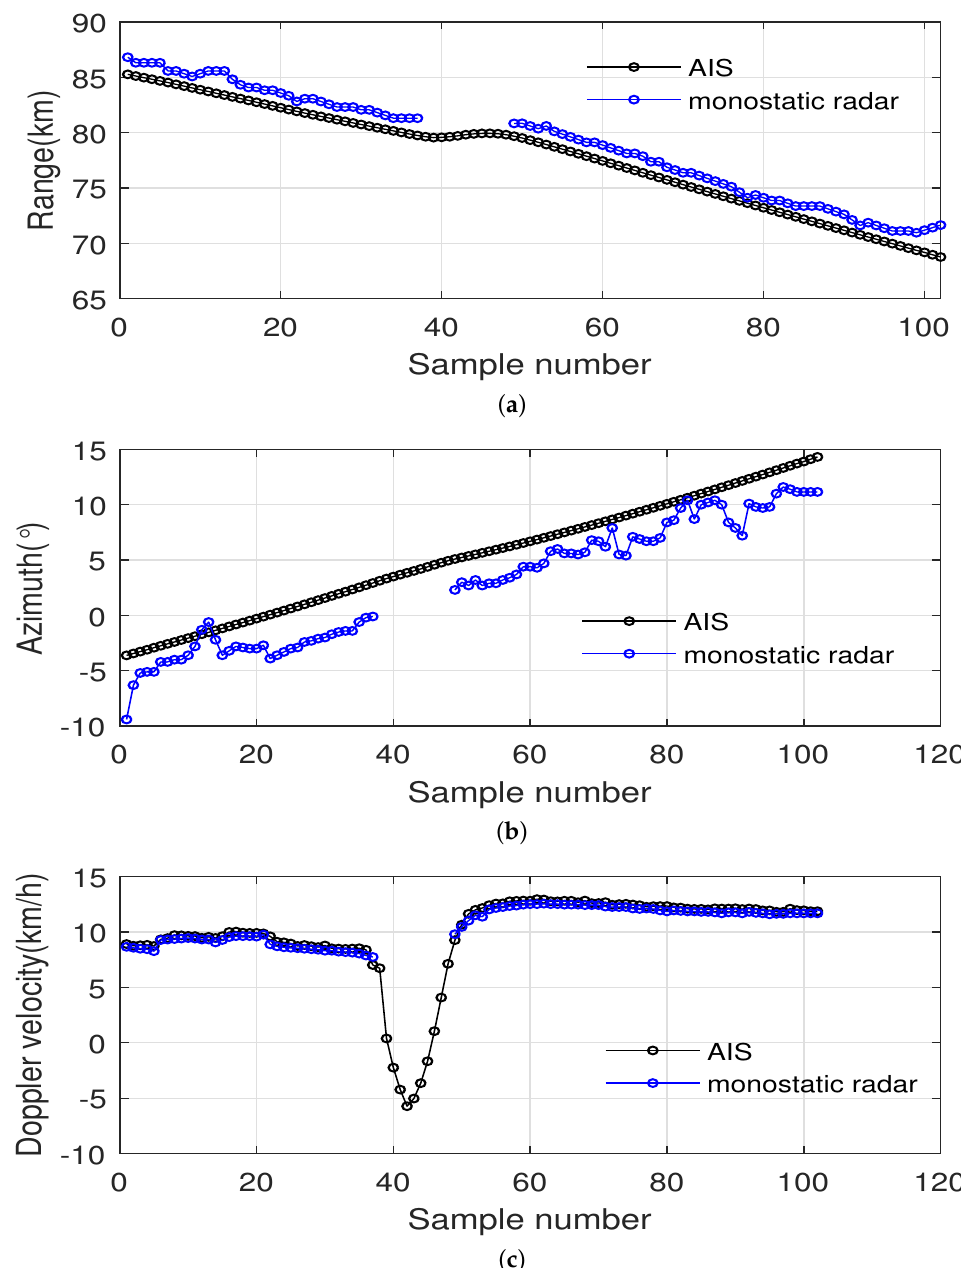
Figure 9. Kinematic parameter comparisons for target 2. ( a ) Range comparison for monostatic radar. ( b ) Azimuth comparison for monostatic radar. ( c ) Doppler velocity comparison for monostatic